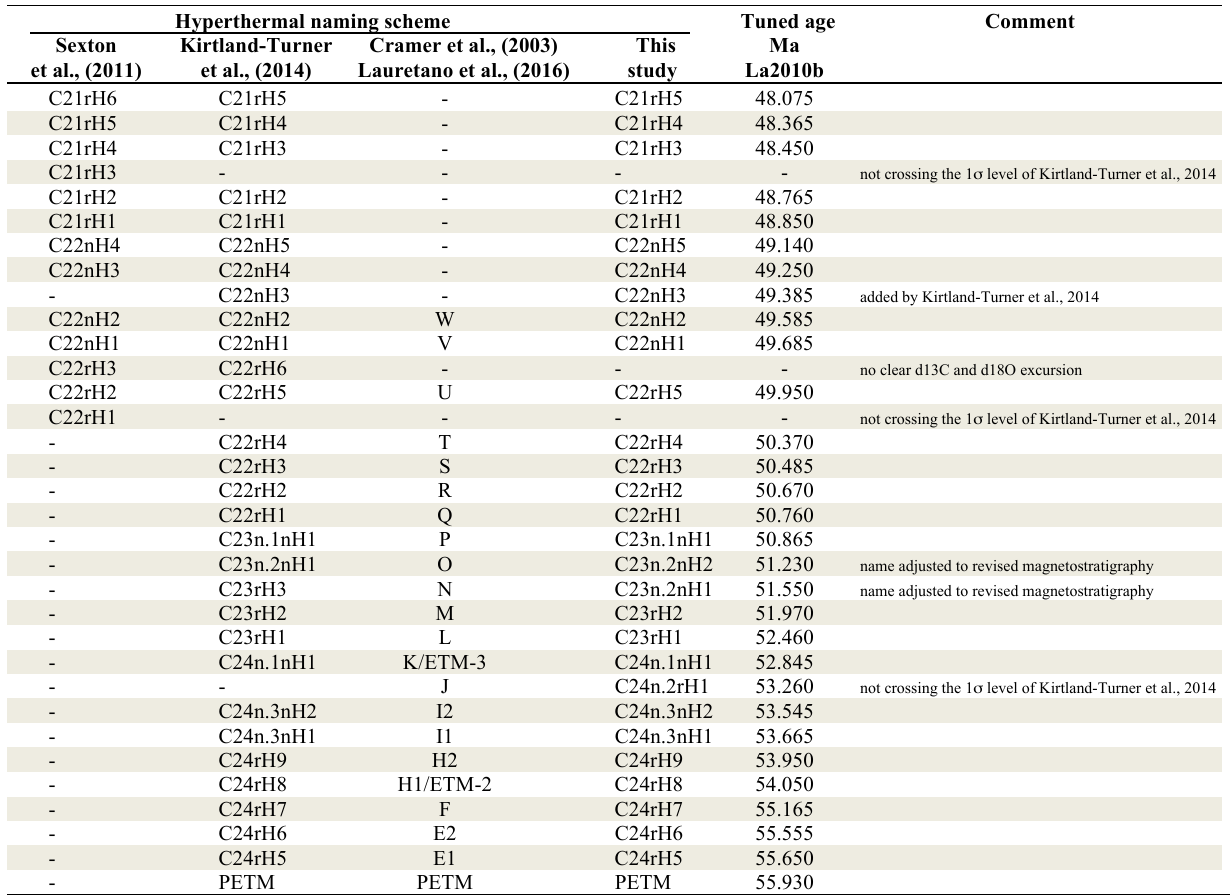
Table 3. Overview of naming and age of hyperthermal events. Hyperthermal naming